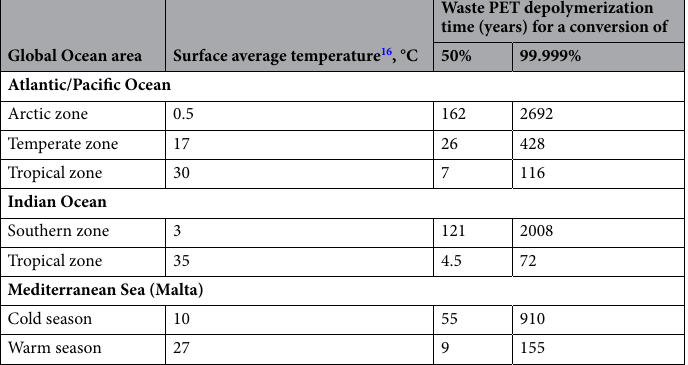
Table 5. Waste PET depolymerization time by natural hydrolysis in marine environment.